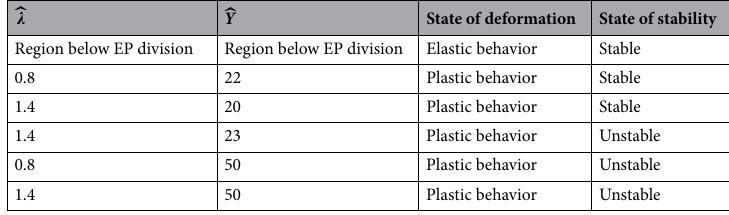
Table 2. Details for results in Fig. 4c,d.